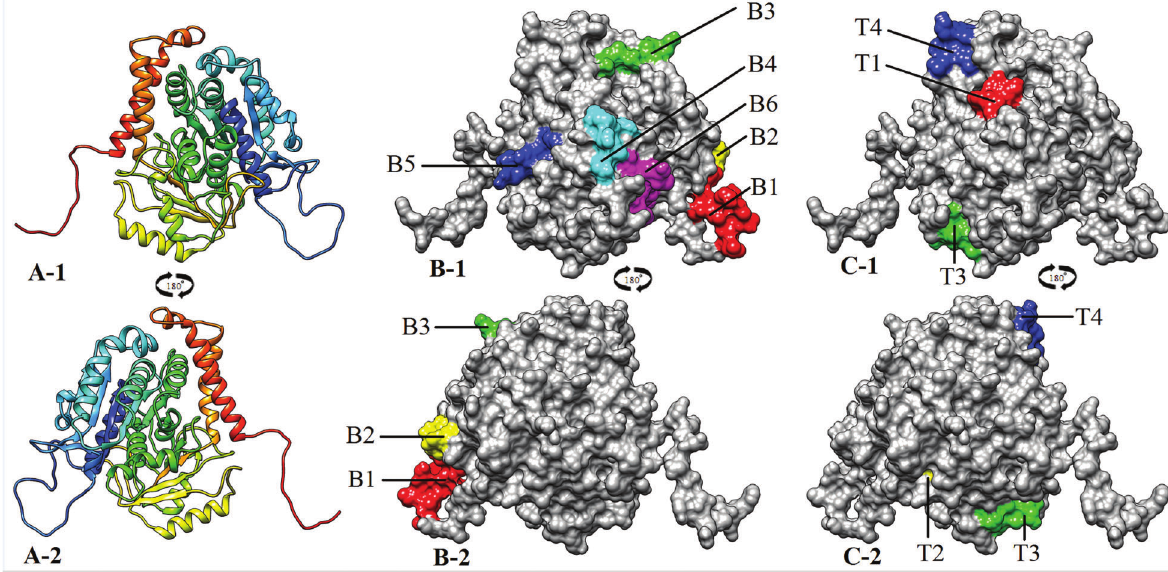
Figure 1. B and T cell epitopes on tertiary structure of Der f 33. A-1 and A-2 , Tertiary structure of Der f 33. B-1 and B-2 , B cell epitopes on tertiary structure of Der f 33. C-1 and C-2 , T cell epitopes on tertiary structure of Der f